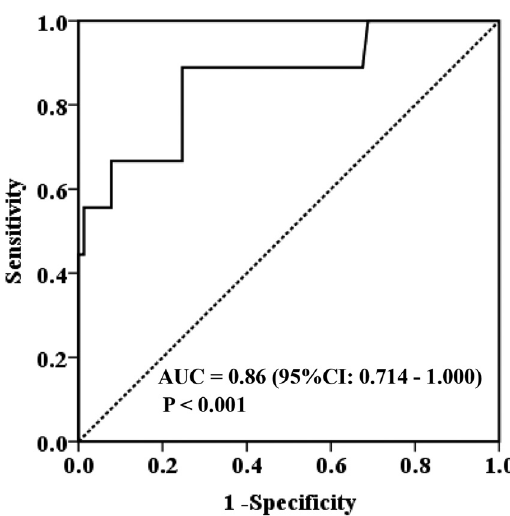
Figure A1: Receiver operator curve ( ROC ) of peak TB concentration predicting in - hospital mortality ( area under the curve: 0.86, 95% CI: 0.714 – 1.000 )